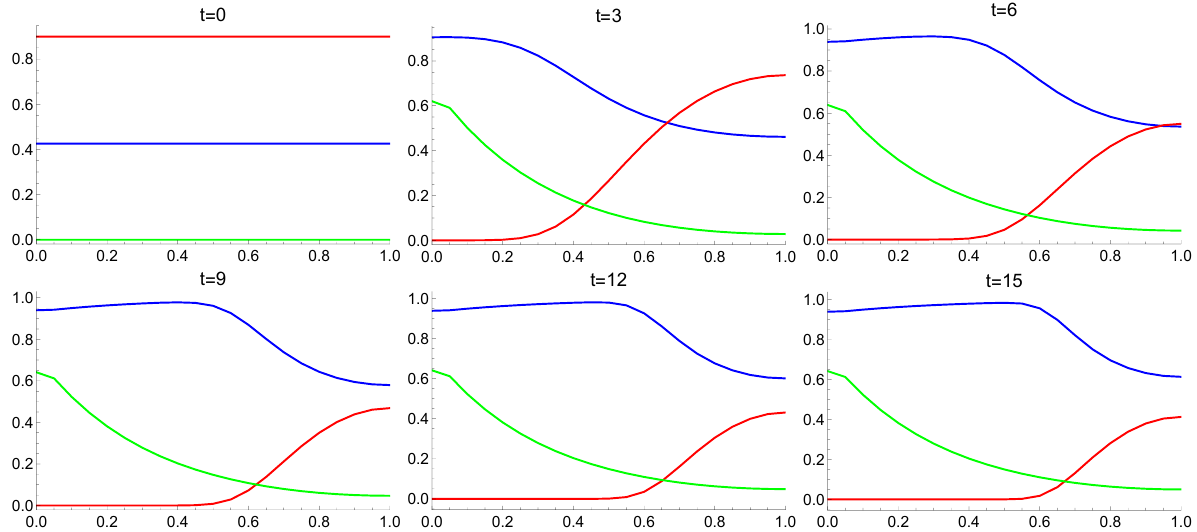
Fig. 2 Results of Simulation 2, with Ω = [ 0 , L ] = [ 0 , 1 ] . Plots of model solutions A ( x , t ) (cancer cells, red), N ( x , t ) (normal cells, blue) and D ( x , t ) (chemotherapeutic drug concentration, green) at time points t = 0 , 3 , 6 , 9 , 12 , 15. See Table 1 for parameter values used here. At time t = 0, the tumor is spread trough the tissue, and as chemotherapy is applied ( t > 0), the tumor cells are reduced and extinct within a given distance from the blood vessel ( x < 0 . 6), but not in the entire tissue ( x > 0 . 6). Within the region of tumor extinction, the removal of tumor cells release the normal tissue to recover and grow.